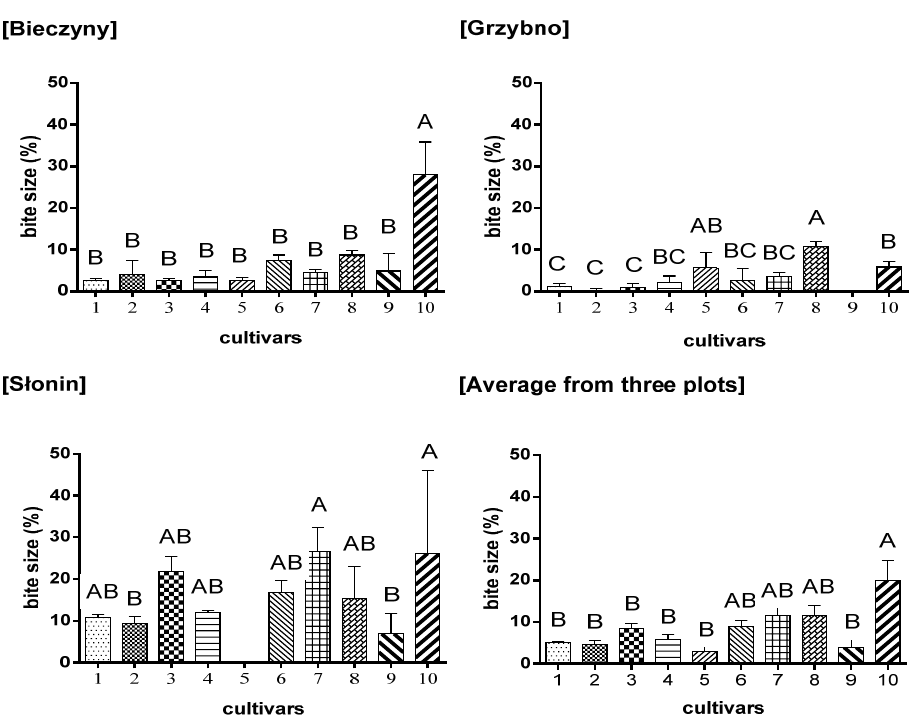
Figure 3. The severity of foraging damage to the analyzed willow cultivars. Bars with the same letters did not differ significantly ( p ≤ 0.01). Symbols: 1–10–numbers of cultivars as in Table 1.